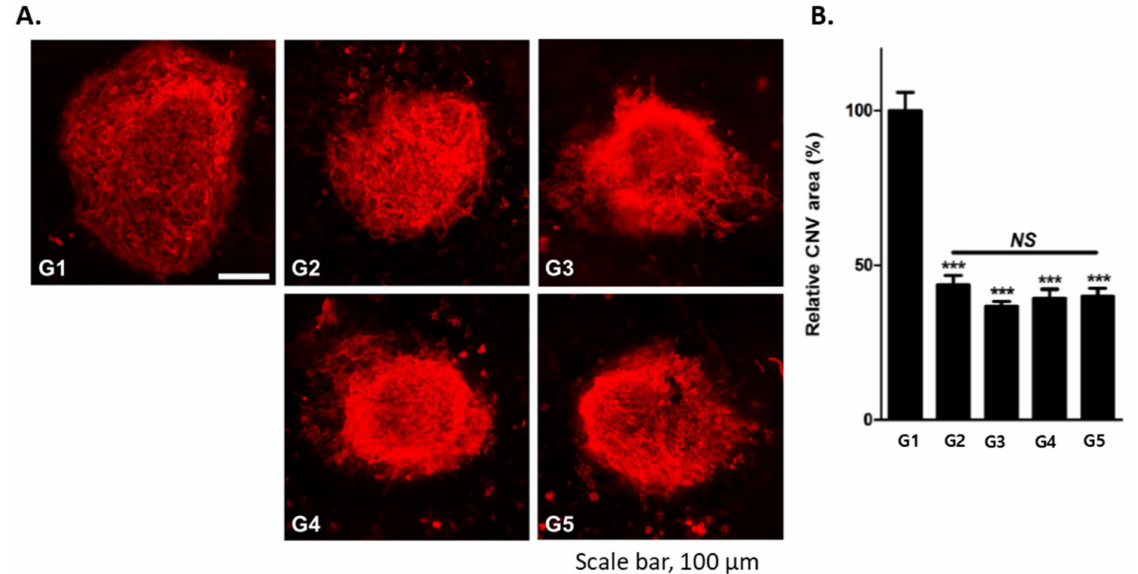
Figure 1. The effects of the intravitreal administration of RLYE, the modified RLYE variants [R (D) LYE and Ac-RLYE], and aflibercept on the area of choroidal neovascularization (CNV) in laser-induced CNV mouse models with treatment initiation on the same day as laser irradiation. ( A ): Representative fundus photography of retinal angiography analyzed by fluorescence microscope on day 7 after laser irradiation. ( B ): A quantitative image analysis results for the area of CNV using the ImageJ software ( n = 6 mice per group). Data are expressed as mean ± S.D. G1: Vehicle control, G2: RLYE 1 ng/1 µ